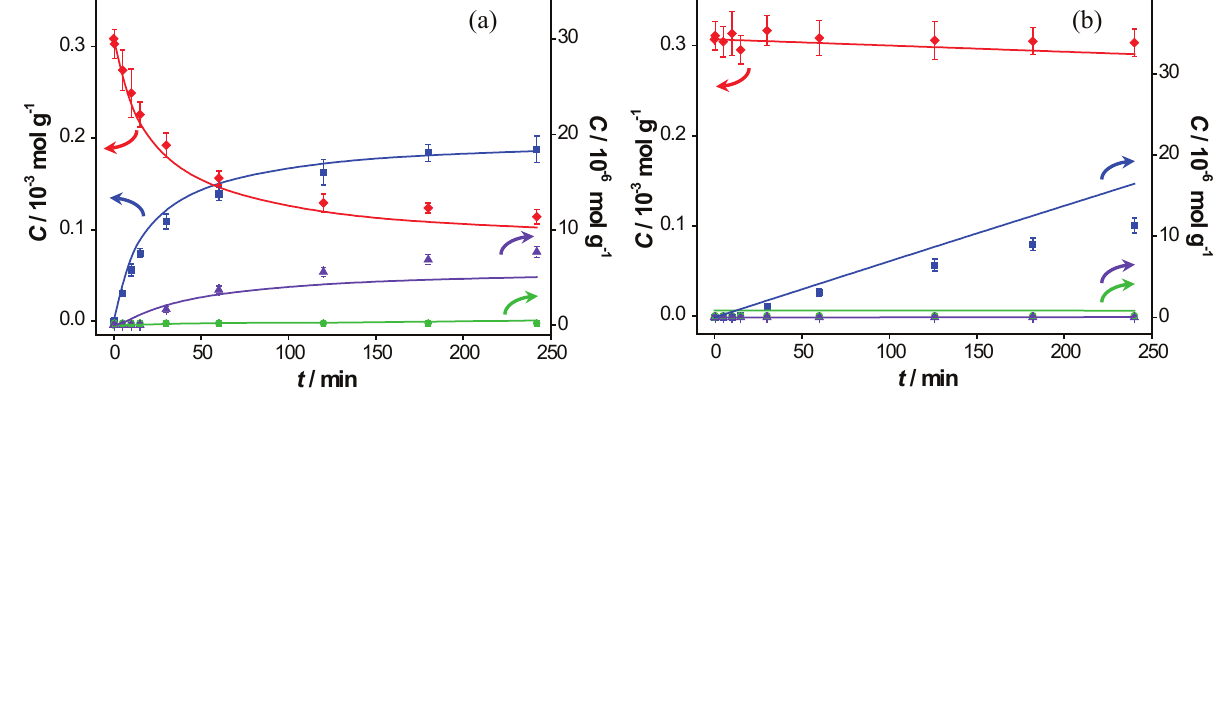
Figure 2. Catalyst performance in base-free conditions. Concentration of ( ♦ ) benzyl alcohol, ( ■ ) benzaldehyde, ( ● ) benzoic acid and ( ▲ ) benzyl benzoate vs. reaction time for ( a ) first run using fresh AUROlite ™ and ( b ) second run using spent AUROlite ™ . Reaction conditions: T = 80 °C, 0.8 g AUROlite ™ , C = 3.0 × 10 − 4 mol · g − 1 in 80 mL of BnOH, t =0 toluene, 200 mL · min − 1 air flow. Concentrations are expressed in moles per unit mass of liquid in the reactor (mol · g − 1 ). The symbols with error bars are the experimental results and the lines represent the kinetic